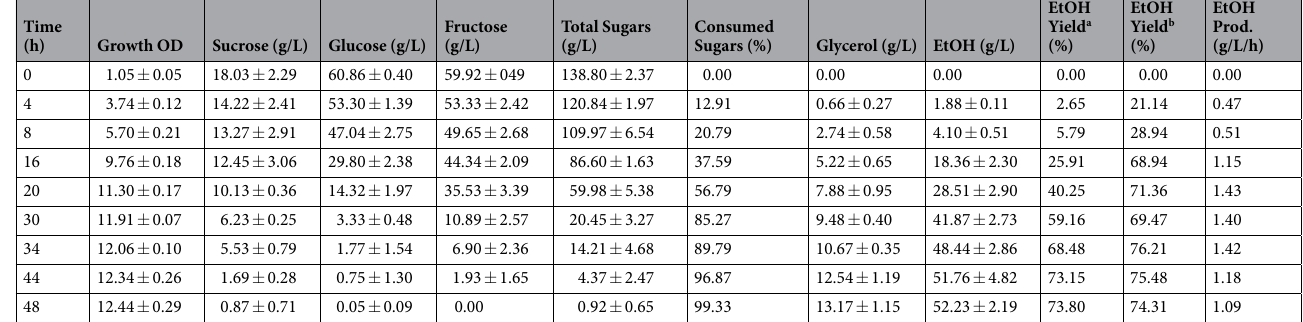
Table 5. HPLC analysis for fermentations conducted in 15-L bioreactors using SW-Molasses media and the marine strain S.cerevisiae AZ65. a Calculated as a percentage of the theoretical yield (0.51) based on the